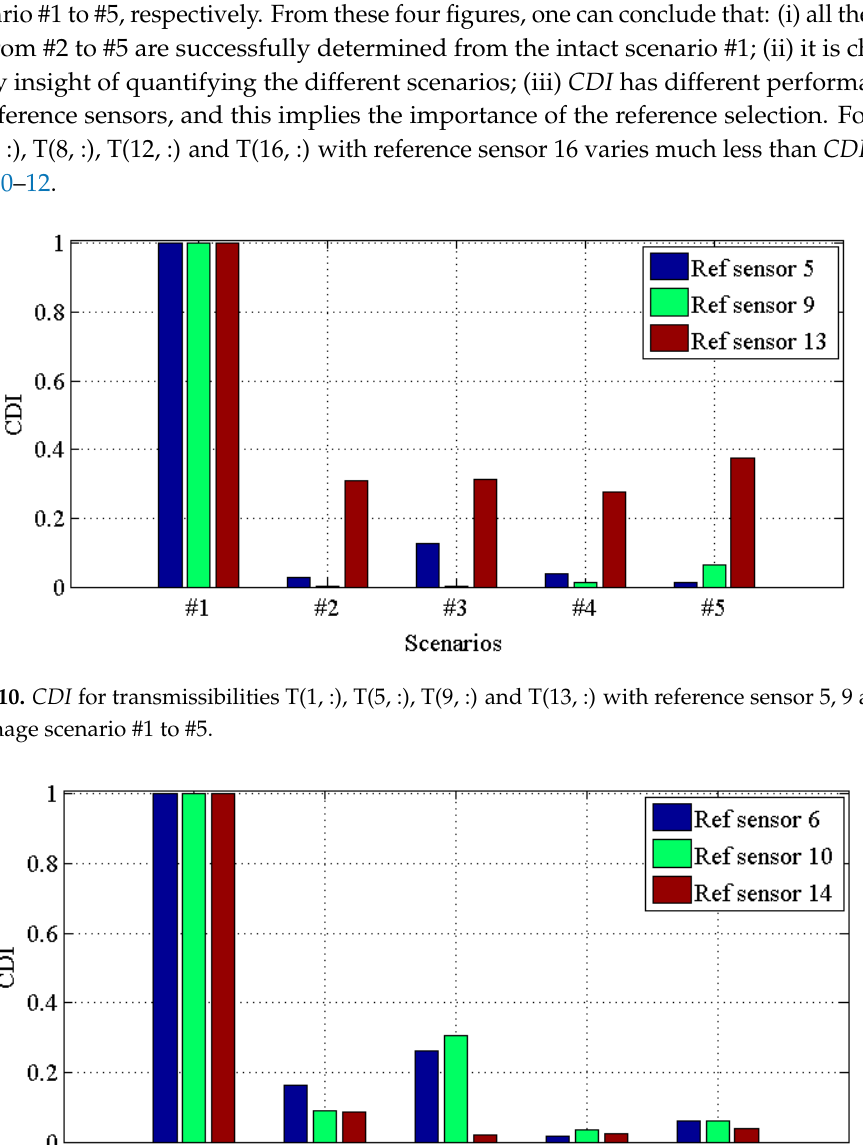
Figure 12. CDI for transmissibilities T(3, :), T(7, :), T(11, :) and T(15, :) with reference sensor 7, 11 and 15 for damage scenario #1 to #5.